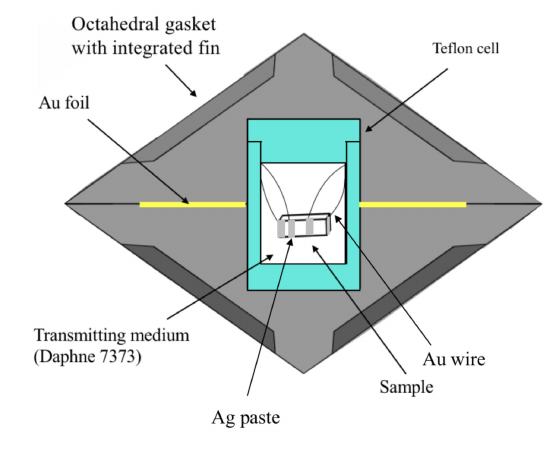
Figure 2: Cross-sectional view of the internal configu- ration of the gasket with teflon cell.